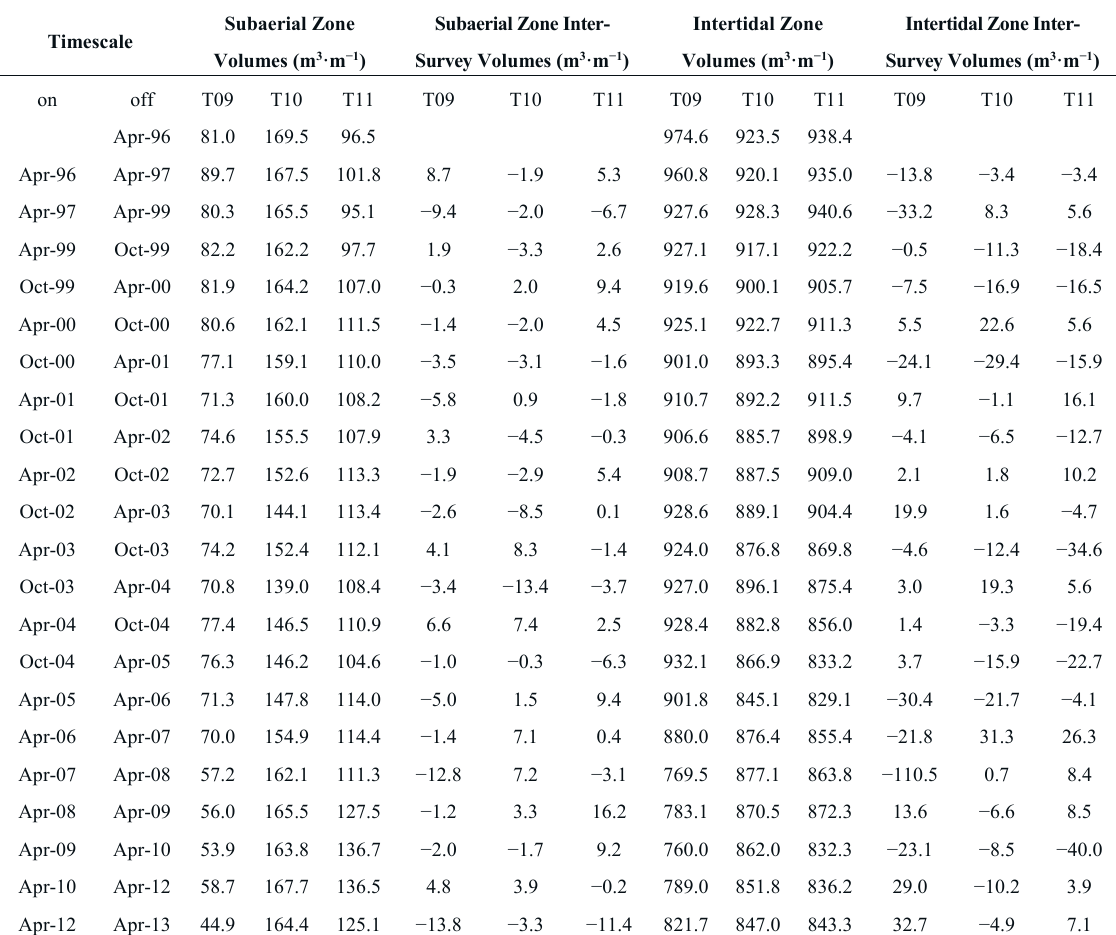
Table 2. Subaerial and intertidal volume change between 1996 and 2013.